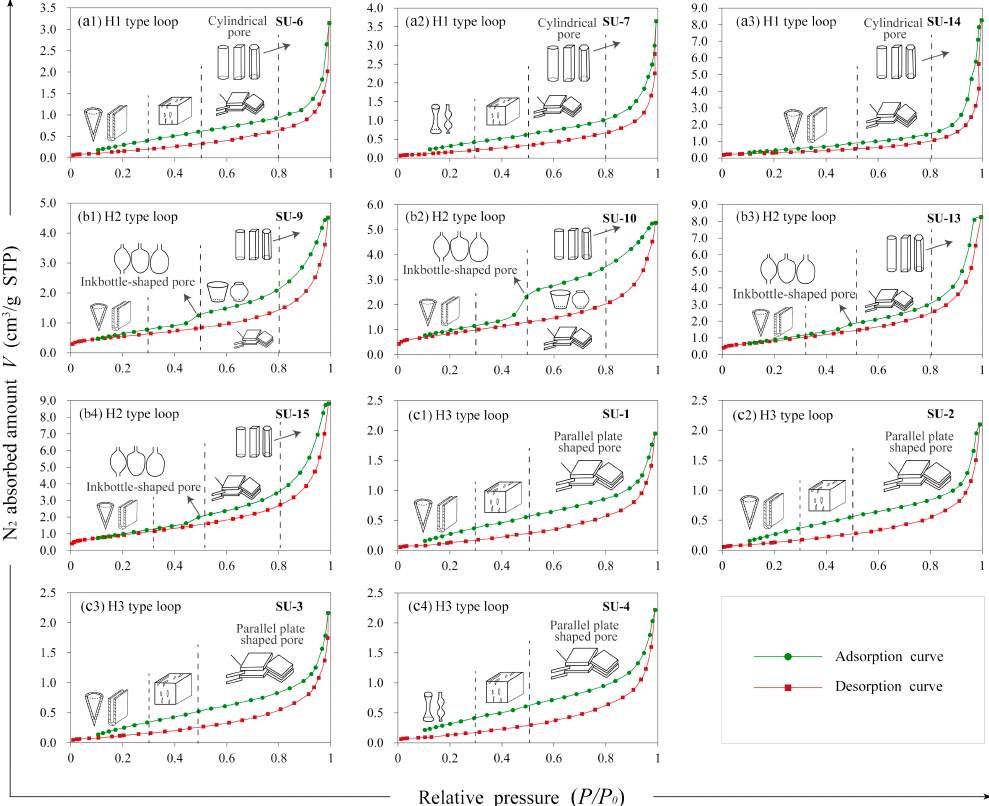
Figure 5. N 2 adsorption / desorption isotherms and the corresponding pore shapes of He 8 Member tight sandstone samples. ( a1 )–( a3 ) Samples with H1 type hysteresis loop; ( b1 )-( b4 ) samples with H2 type hysteresis loop; ( c1 )–( c4 ) samples with H3 type hysteresis loop.